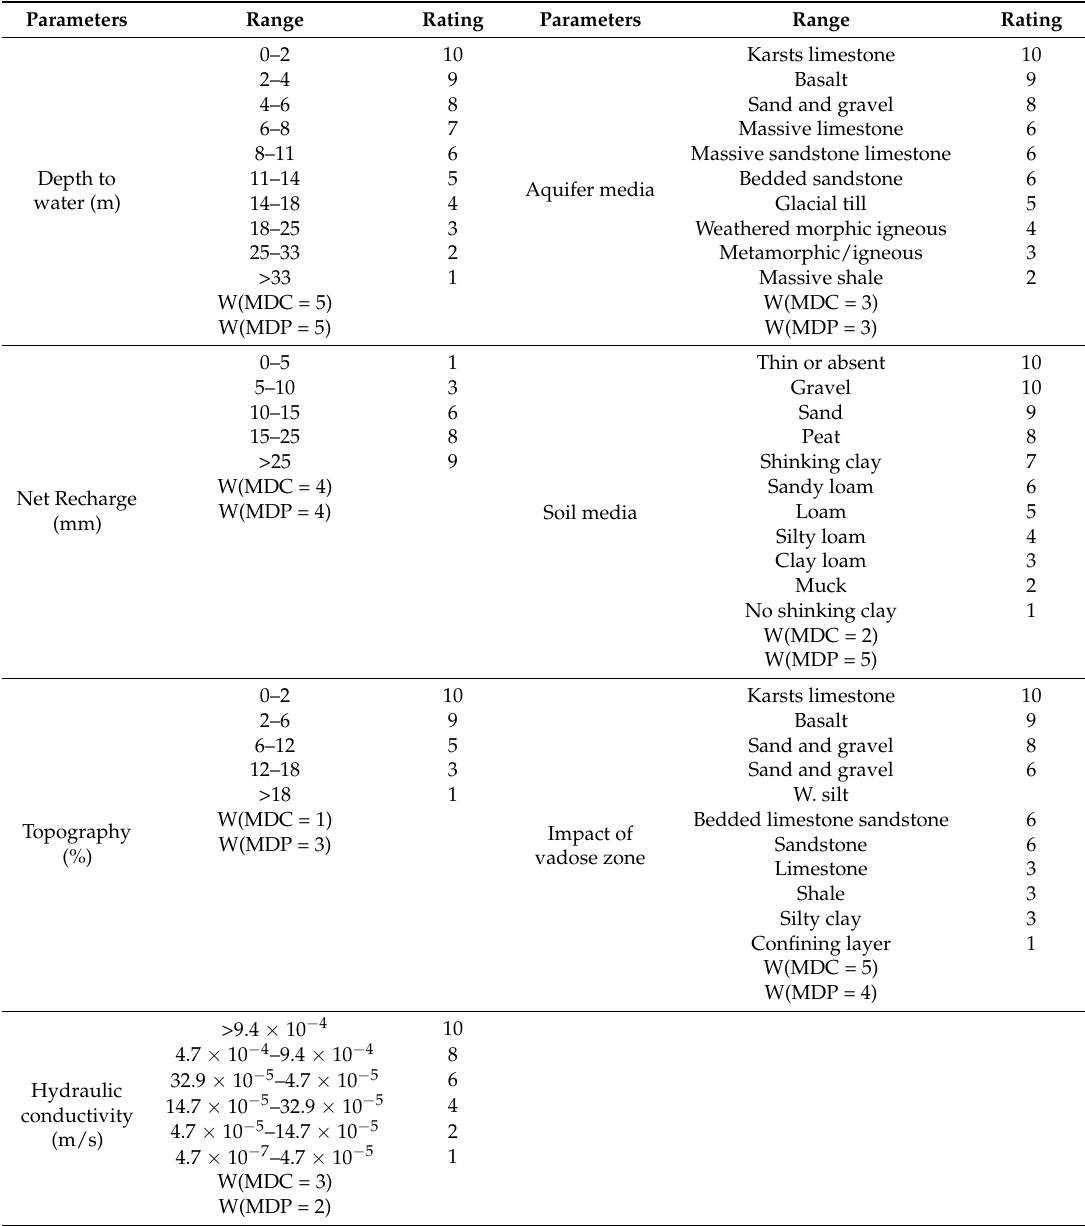
Table 2. Original DRASTICs (MDC and MDP) rate and weight [24]. MDC: classic DRASTIC model; MDP: pesticide DRASTIC